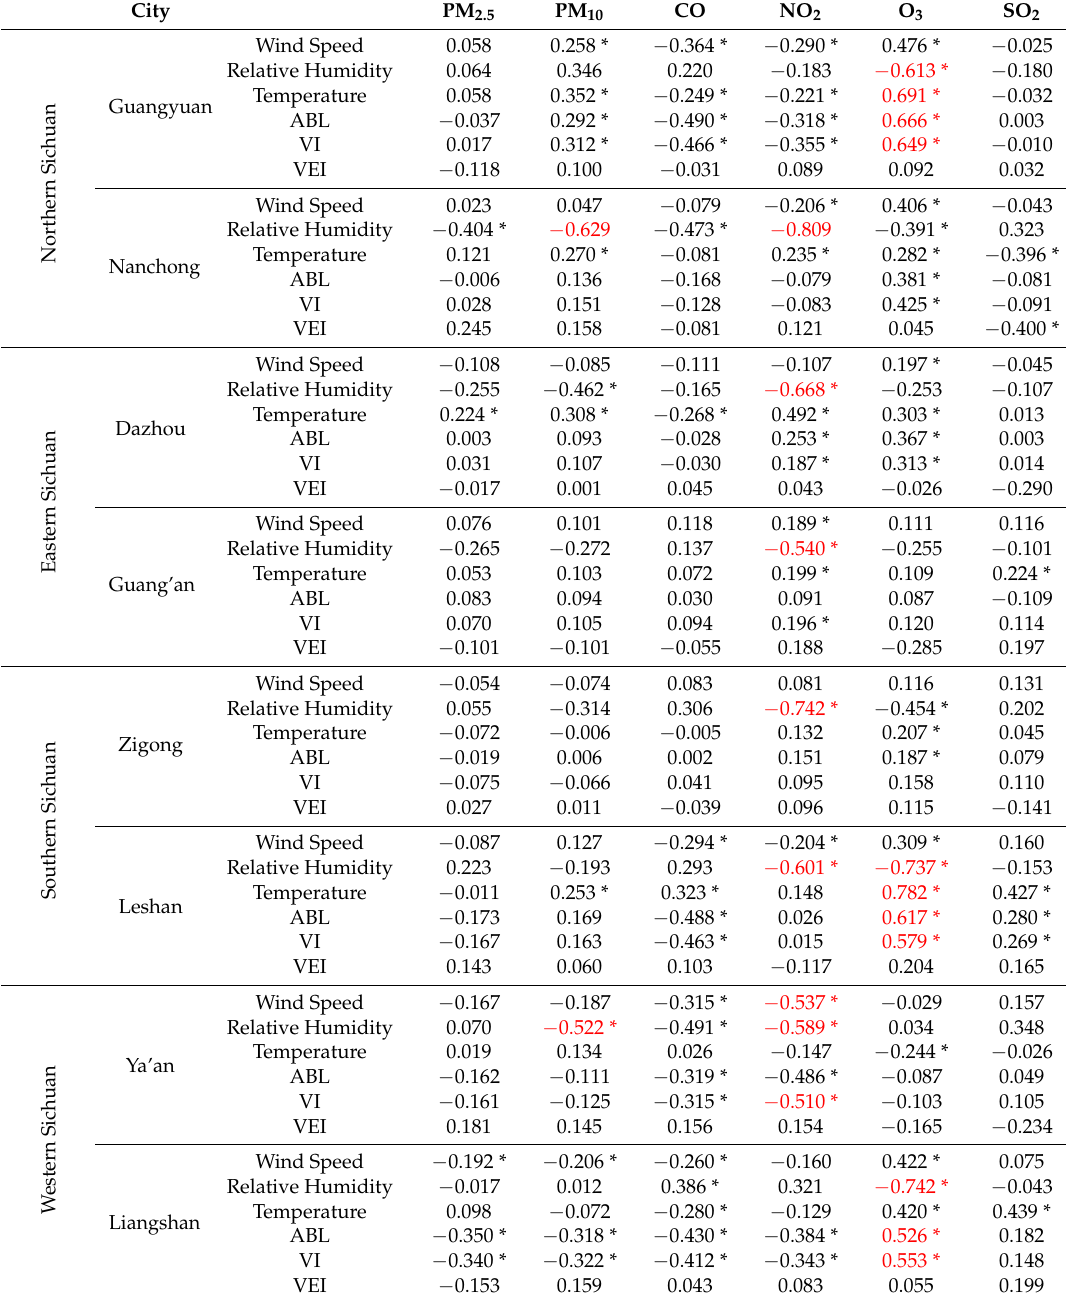
Table 3. The correlation coefficients between the concentrations of pollutants and meteorological factors in the eight chosen cities. The numbers in red represent strong correlations (|R| > 0.5) between the corresponding